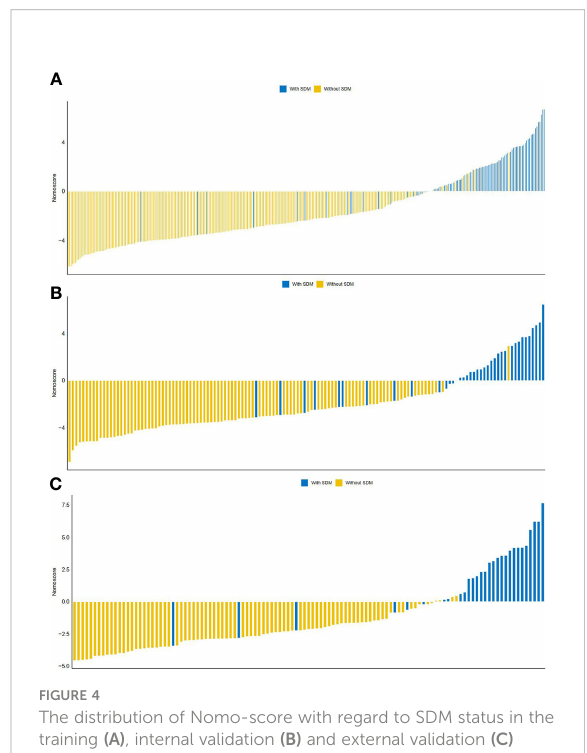
FIGURE 4 The distribution of Nomo-score with regard to SDM status in the training (A) , internal validation (B) and external validation (C)